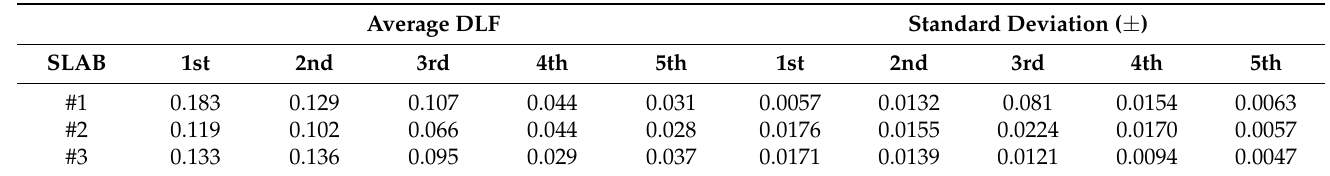
Table 5. Average trend and standard deviation of DLF values of normal walk ( f p = 1.5 Hz), as obtained from experimental records for vertical force component on different substructures (with 8 walking records for SLAB#1, 10 for #2 and 9 for #3 and a single adult pedestrian volunteer). Average DLF Standard Deviation ( ± )